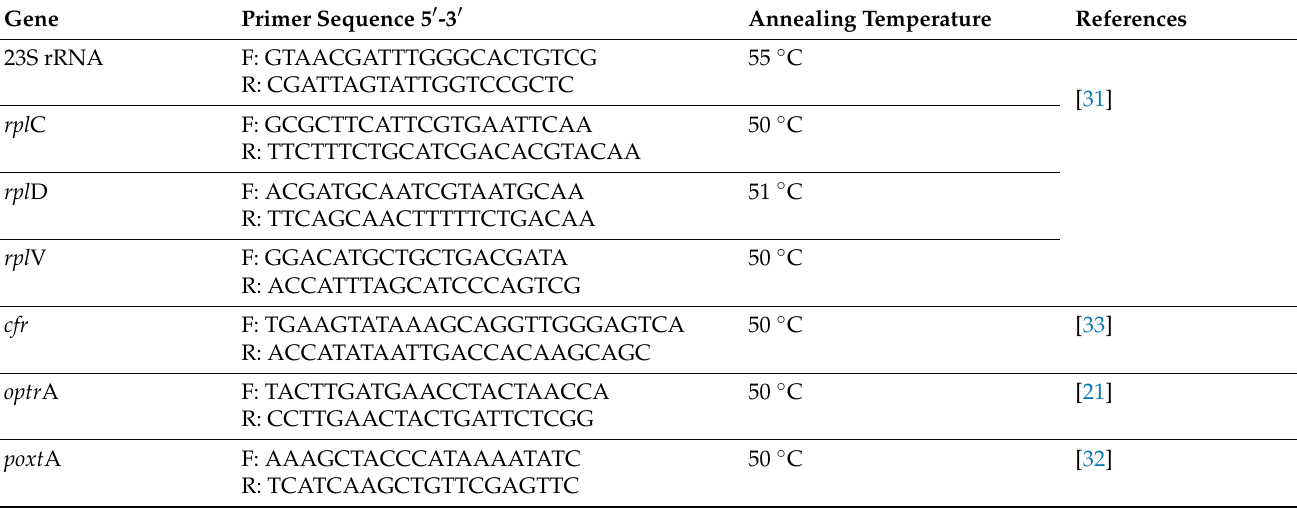
Table 1. Oligonucleotides used in the